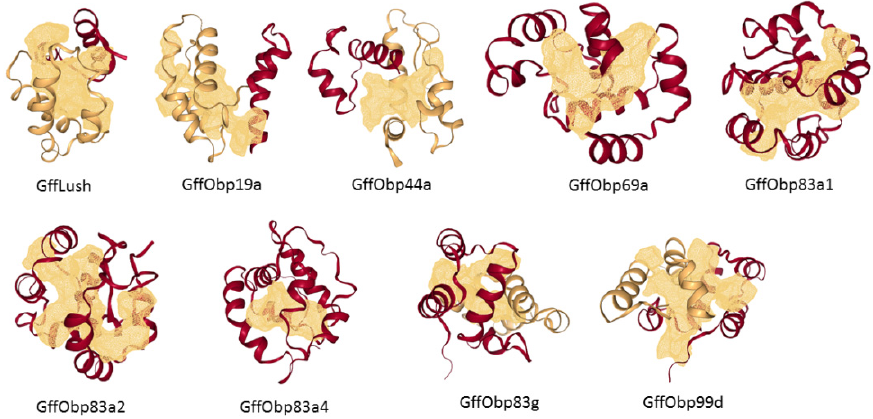
Figure 2. Structural features of nine odorant-binding proteins of Glossina f. fuscipes. 3D structure showing the α -helices. Gold color shows the protein surface topology, highlighting the binding pocket.